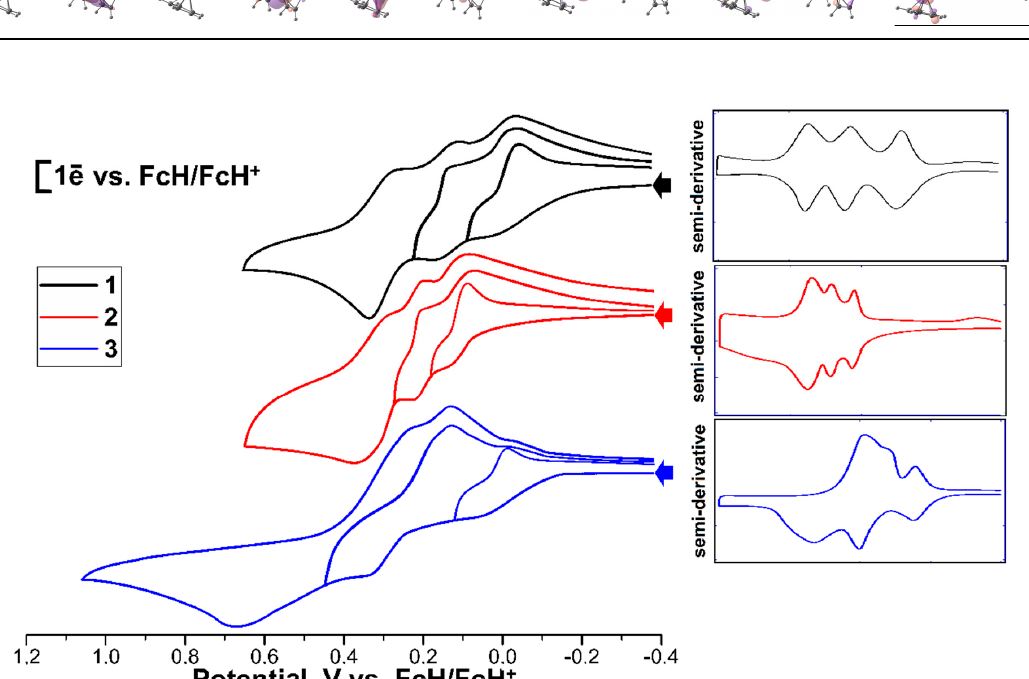
Figure 2. Cyclic voltammograms for oxidation of 1–3 . Conditions: 0.5 mM solutions of 1–3 in CH 3 CN, 0.1 M [NBu 4 ][BF 4 ]; working electrode: glassy carbon; 10 mVs − 1 , peak potential in V ref. Ag/AgCl recalculated to FcH/FcH + .